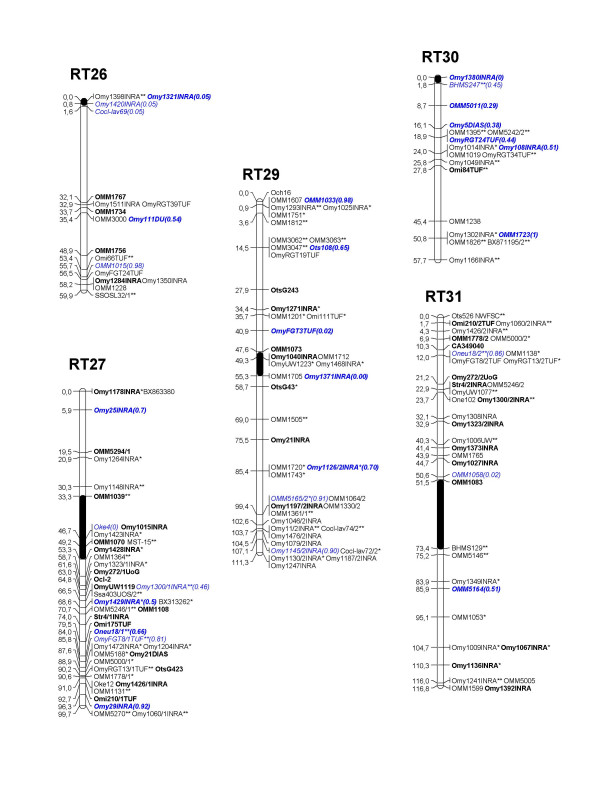
Graphic representation of linkage groups RT26 to RT31 (RT28 does not exist). Legends are the same as in Figure 1.